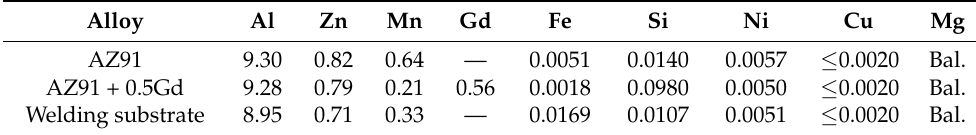
Figure 1. Schematic diagrams of ( a ) surface welding process and ( b ) sampling location. Table 1. Chemical composition of welding wires and basic metal (wt%).